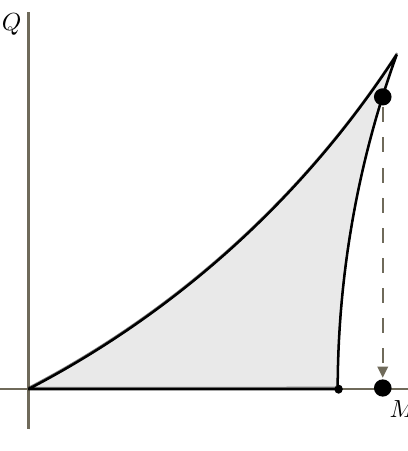
Figure 1 . Charge versus mass plot for Reissner-Nordstrom-de Sitter black holes. Sub-extremal solutions (those without naked singularities) only exist inside the gray-shaded “shark-fin”-shaped region. Unlike in flat space, there is a maximal value of the mass for a given value of the charge (the right-side edge of the shaded region); this corresponds to the so-called Nariai black hole, for which the cosmological and black-hole horizons coincide. A Nariai black hole with some charge Q amd M can decay following the dashed line if there exist particles in the spectrum that violate the FL bound, becoming super-extremal and thus producing a pathological spacetime that does not evaporate back to empty de Sitter space. The FL bound is the condition that these pathological decays do not